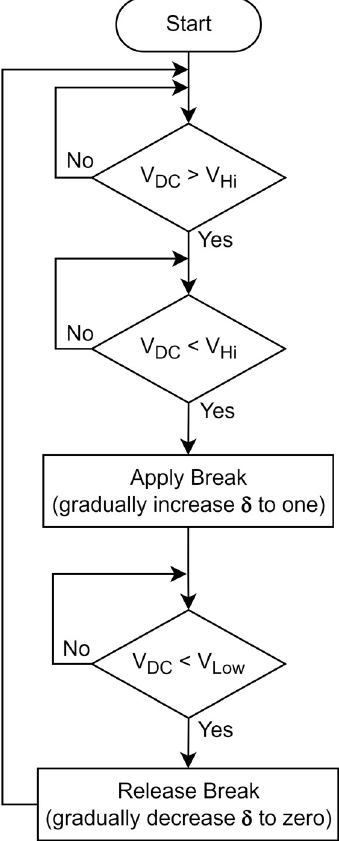
Figure 22. Chopper programming sequence to improve energy performance.